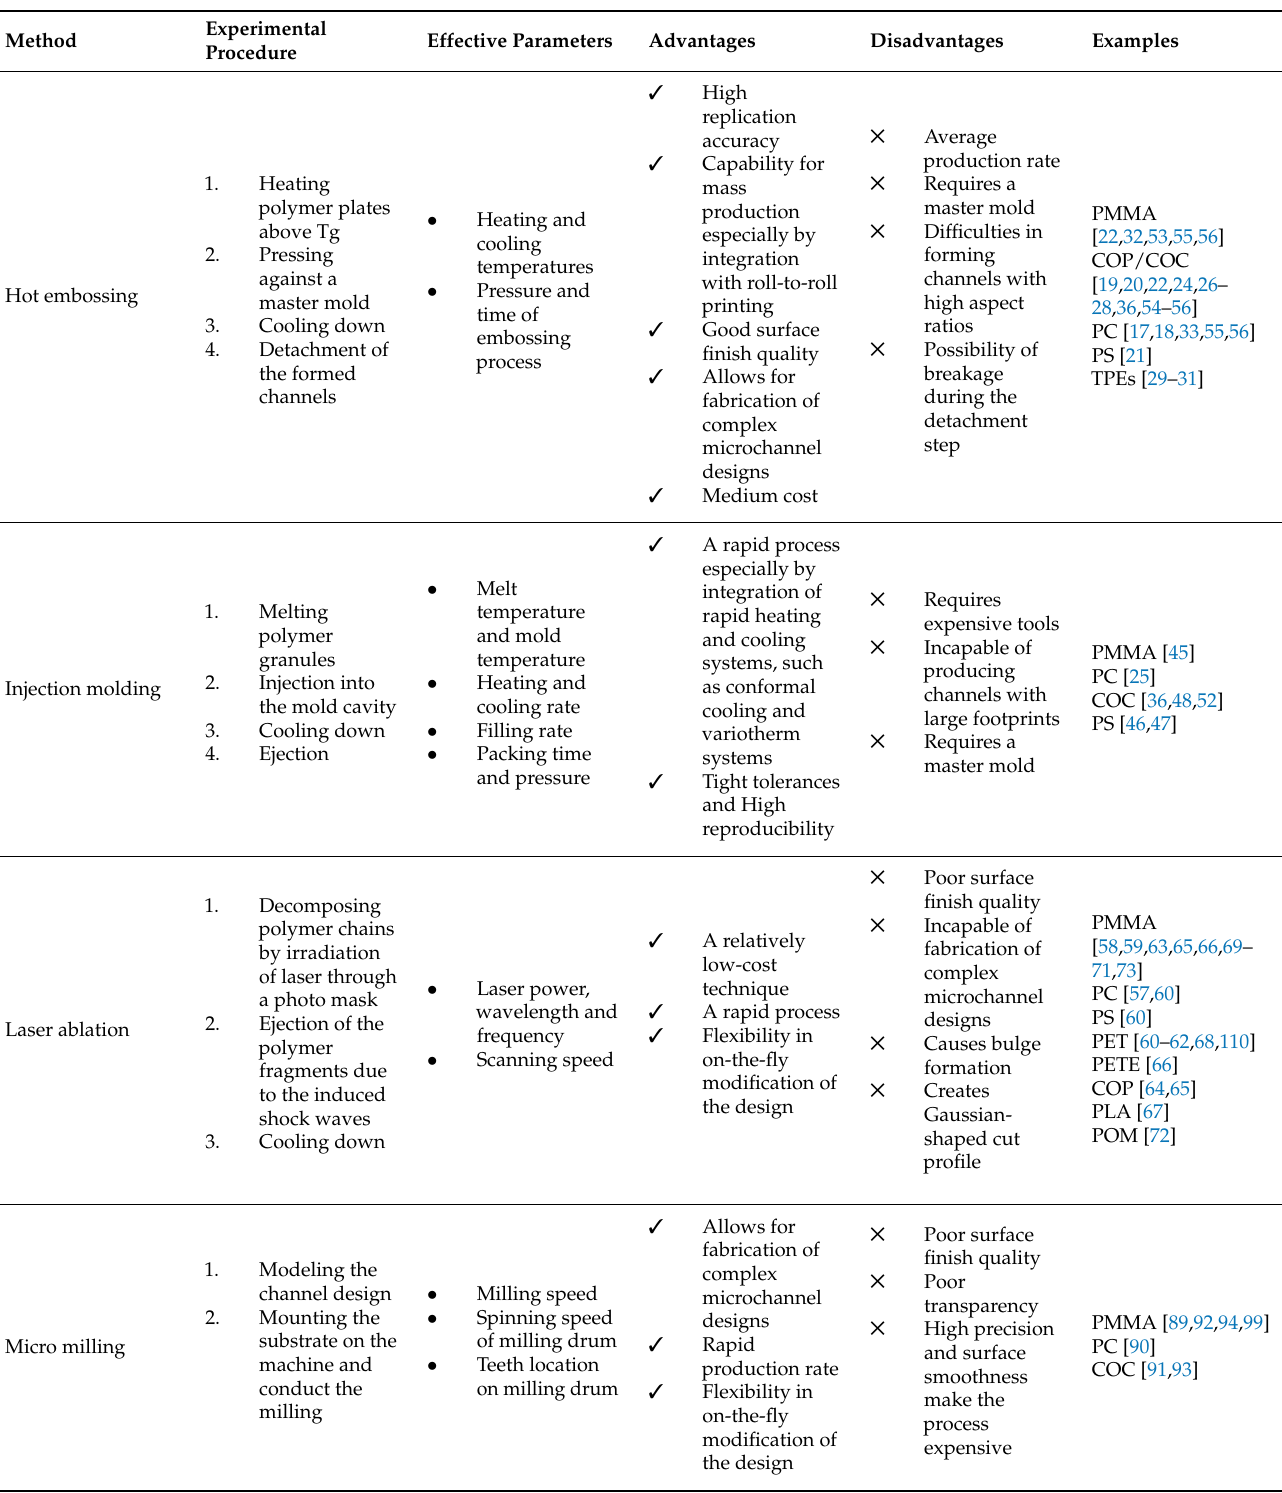
Table 1. Common approaches for forming